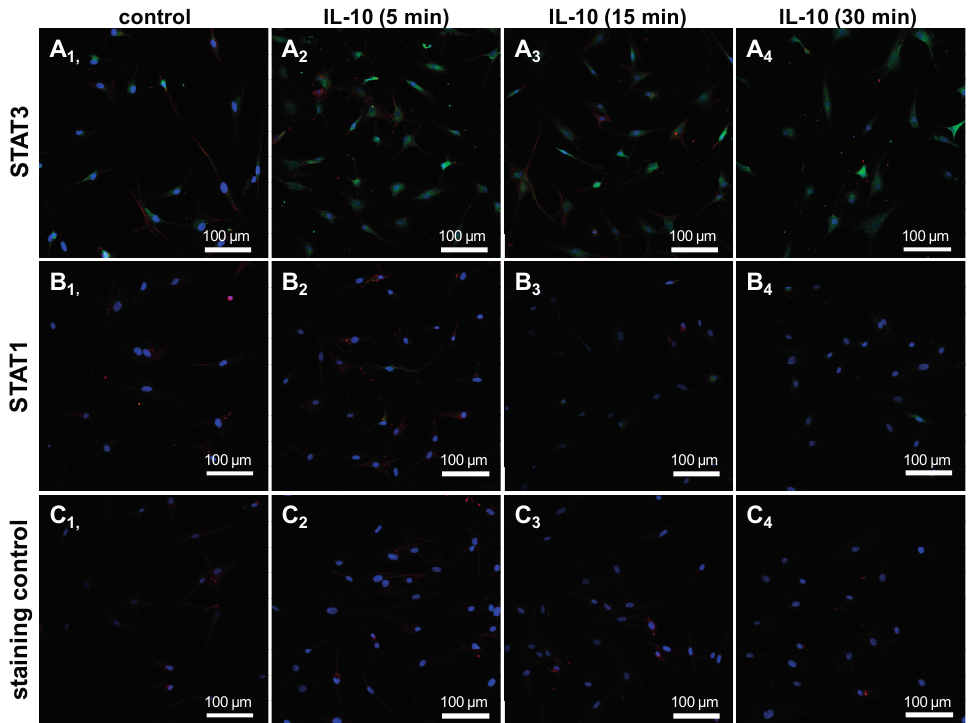
– A ) or STAT1 ( B – B ) specific 1 4 1 4 – C ). Cell nuclei were counterstained using DAPI 1 4